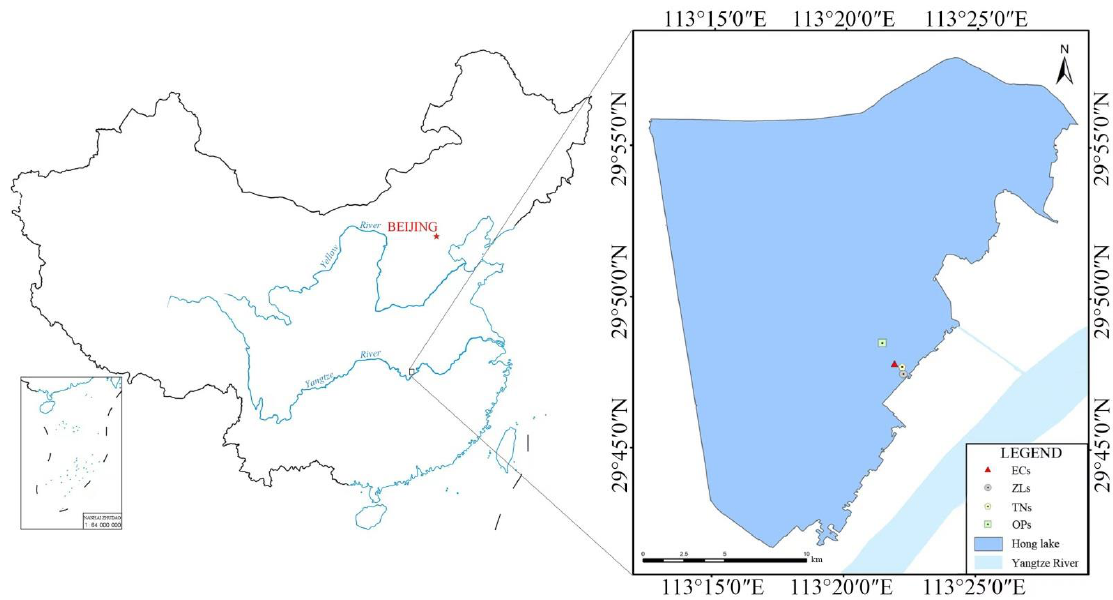
Figure 1. The study was conducted at Hong Lake in the middle reaches of the Yangtze River.